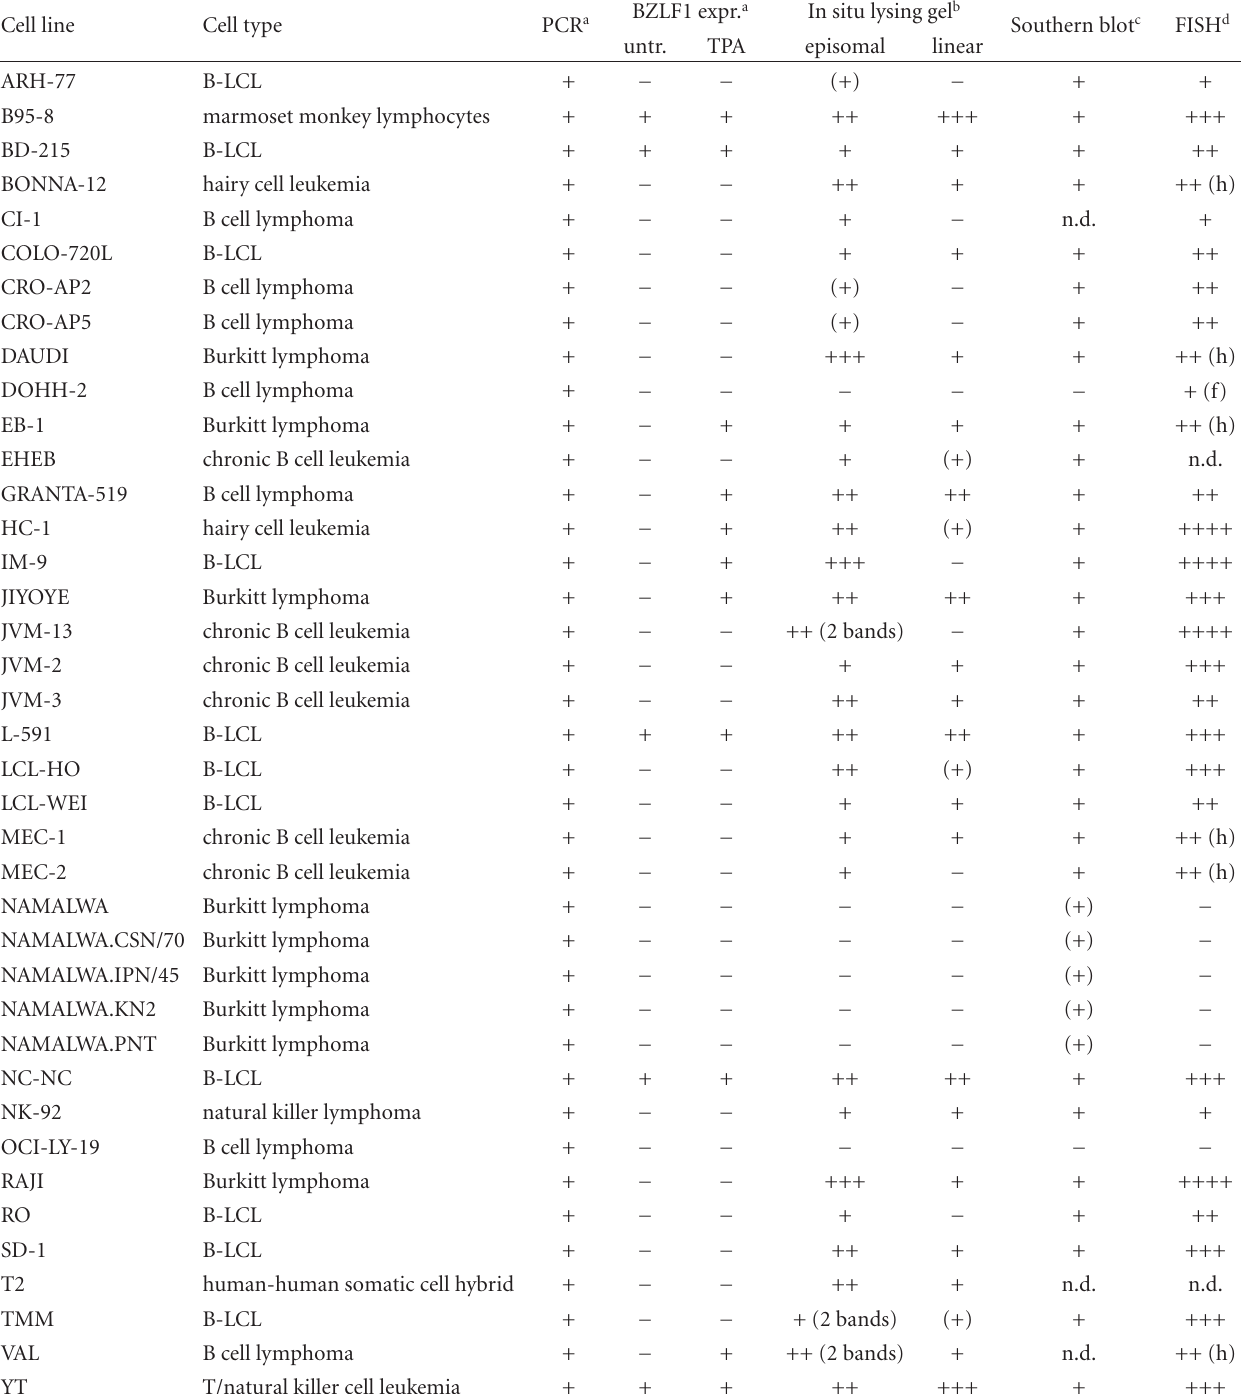
Table 2: EBV-PCR+ cell lines, BZLF1 expression detected by Western blotting, di ff erentiation of episomal and linear EBV-DNA, EBV sequence pattern detected by Southern blotting, and episomal load determined by